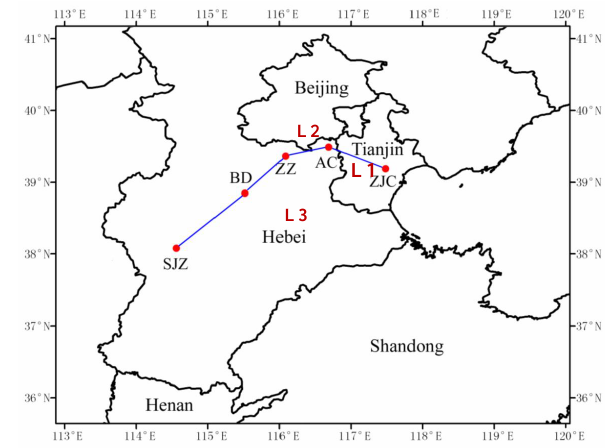
Fig. 1 The three flight routes during the aircraft sampling periods (ZJC, AC, ZZ, Fig. 1. The three flight routes during the aircraft sampling periods BD, and SJZ means the start and end sampling sites Zaojiacheng, Anci, (ZJC, AC, ZZ, BD, and SJZ mean the start and end sampling sites Zaojiacheng, Anci, Zhuozhou, Baoding and Shijiazhuang).